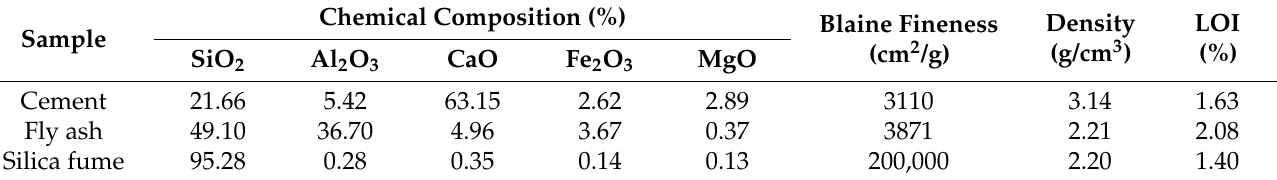
Table 1. Properties of the pozzolanic materials.